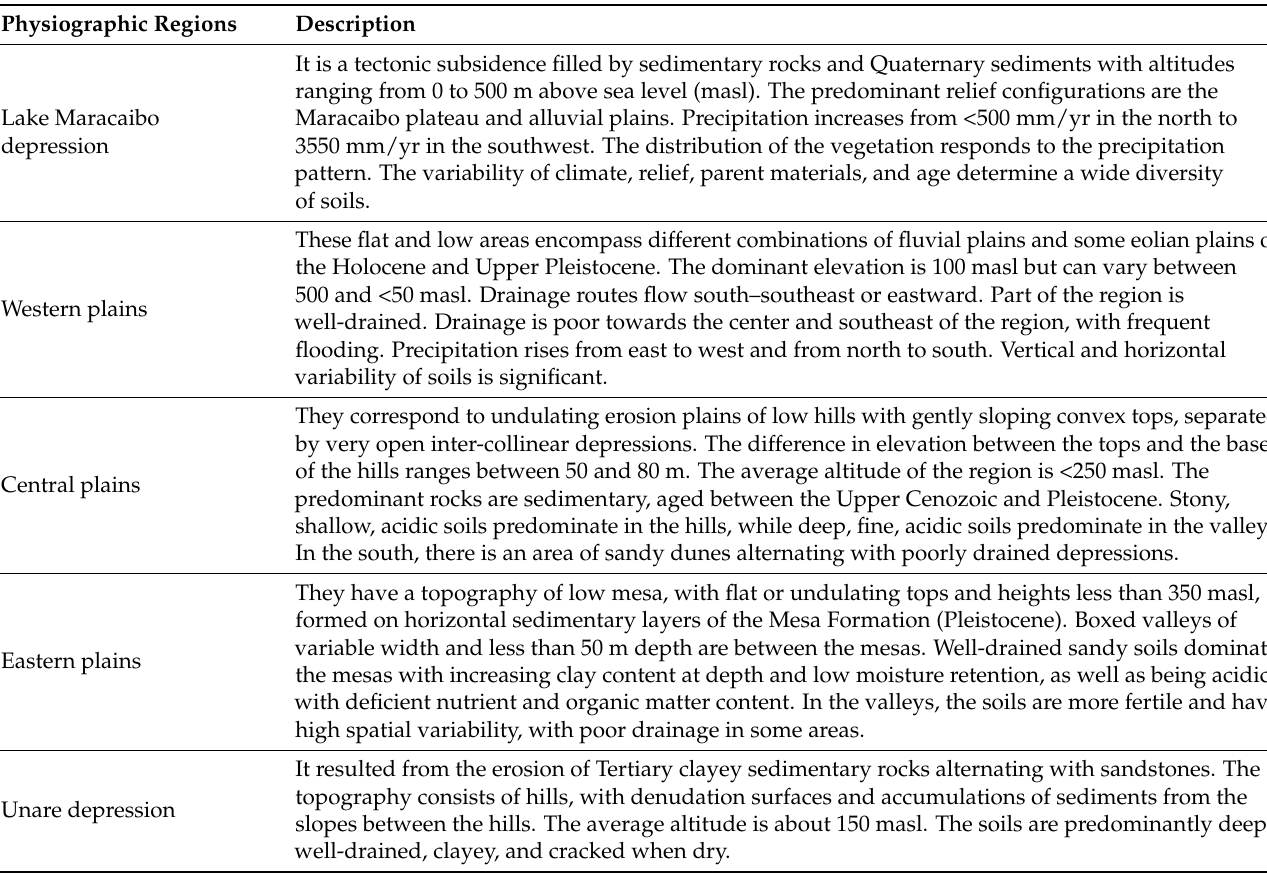
Table A1. Physiographic regions of the plains north of the Orinoco River according to Elizalde et al.